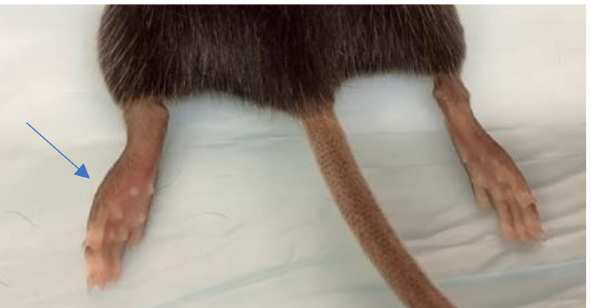
Figure 2. Foot swelling in inoculated foot (arrow) 7 days post inoculation. Note swelling appreciated in the left foot without swelling in the non-inoculated right foot.